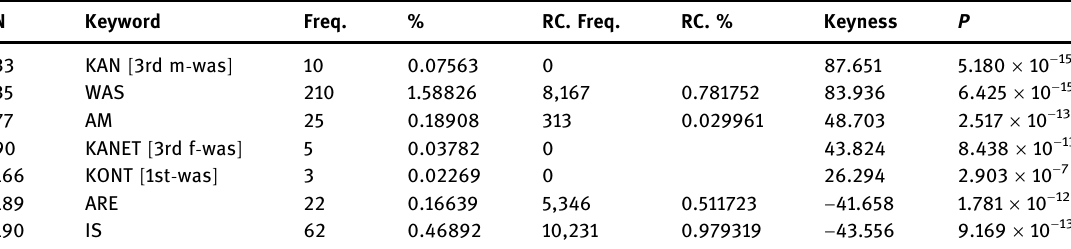
Table 4: Relational processes in the keyword list